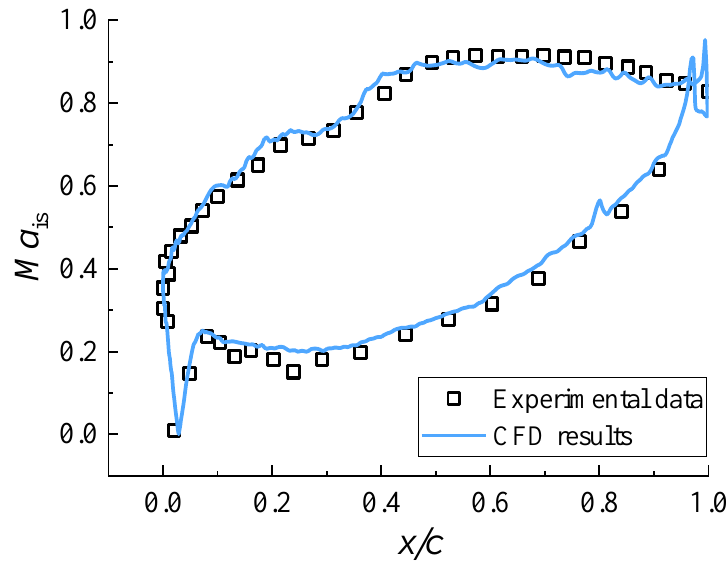
Figure 8. Comparison of isentropic Mach number on the blade surface.